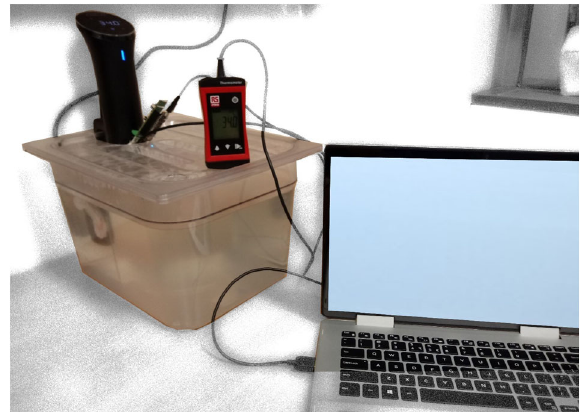
Fig. 3 Water bath testing set up showing the precision temperature being set by a heater. The temperature of a 9 l water bath was set to 34.0 °C. An Input Wired Digital Thermometer and the instrumented mouthguard were sampled by the PC GUI program using a MAX30208 Evaluation System. Both the sensor of the Wired Digital Thermometer and the mouthguard are submerged in the water